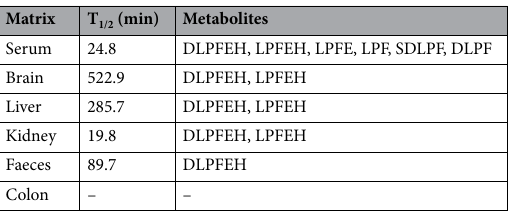
Table 3. Peptide half-lives and formed metabolites in different biological matrices.